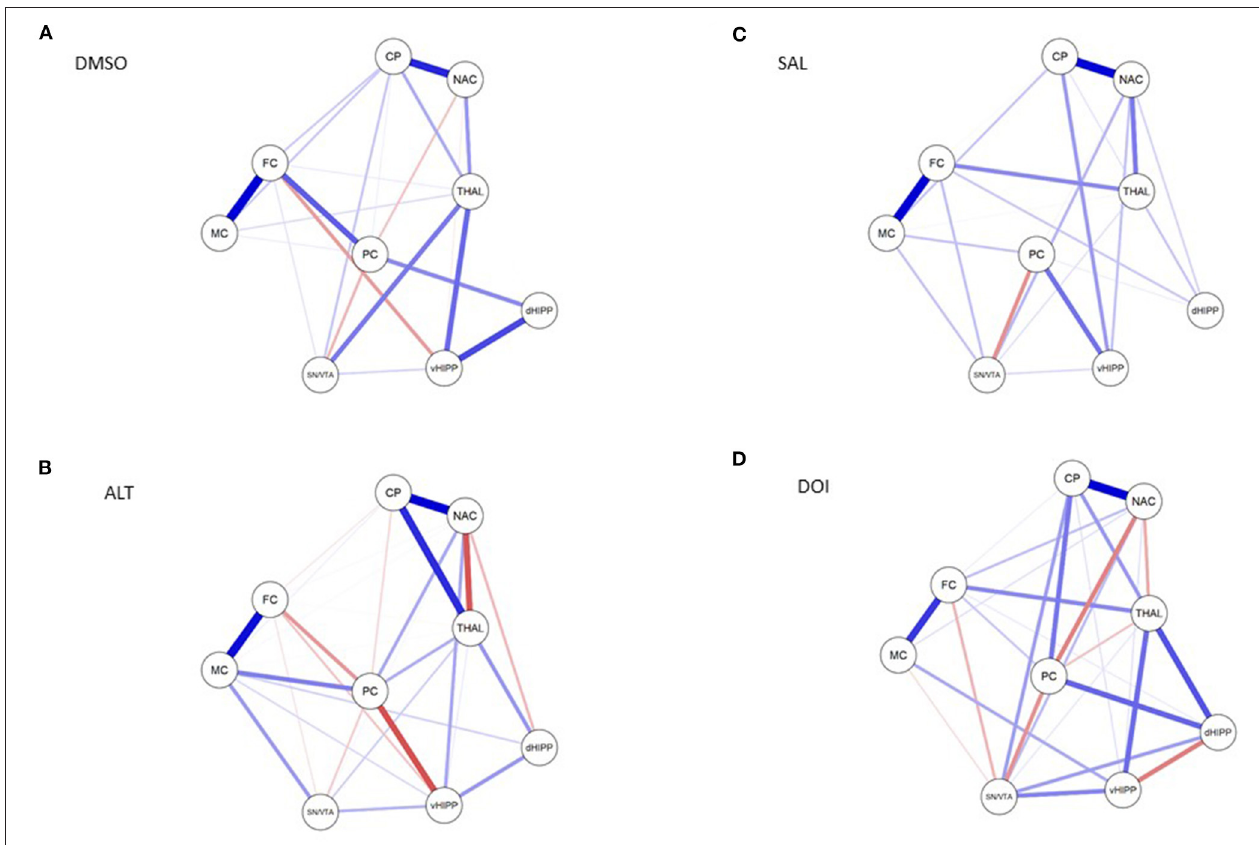
FIGURE 5 | Connections between nucleus accumbens (NAC), caudate putamen (CP), thalamus (THAL), substantia nigra/ventral tegmental area (SN/VTA), frontal cortex (FC), motor cortex (MC), parietal cortex (PC), dorsal hippocampus (dHIPP), and ventral hippocampus (vHIPP) obtained after (A) dimethyl sulfoxide (DMSO), (B) altanserin (ALT), (C) saline (SAL), and (D) 2,5-dimethoxy-4-iodoamphetamine (DOI) application. Positive and negative associations are represented by blue and red lines, respectively. The size of the lines indicates the strength of the individual connections. Models were estimated with JASP (version 0.10.2.0, © 2013–2019 University of